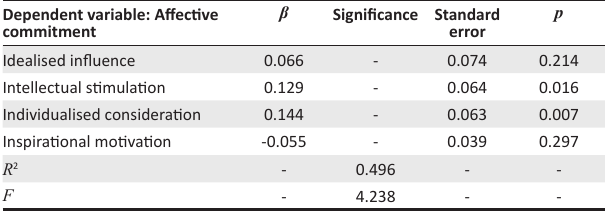
TABLE 5: Transformational leadership style constructs as predictors of affective